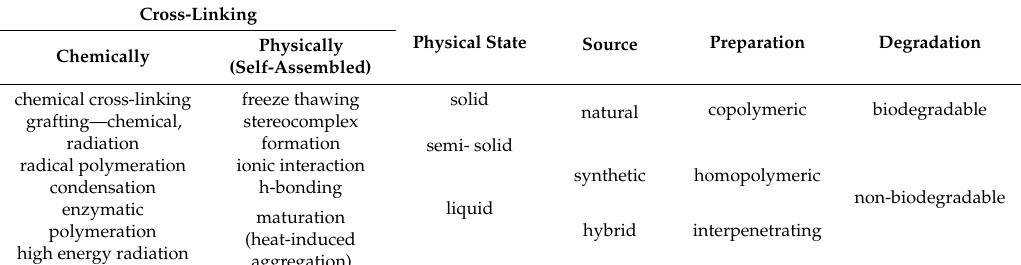
Table 2. Classification of hydrogels based on different